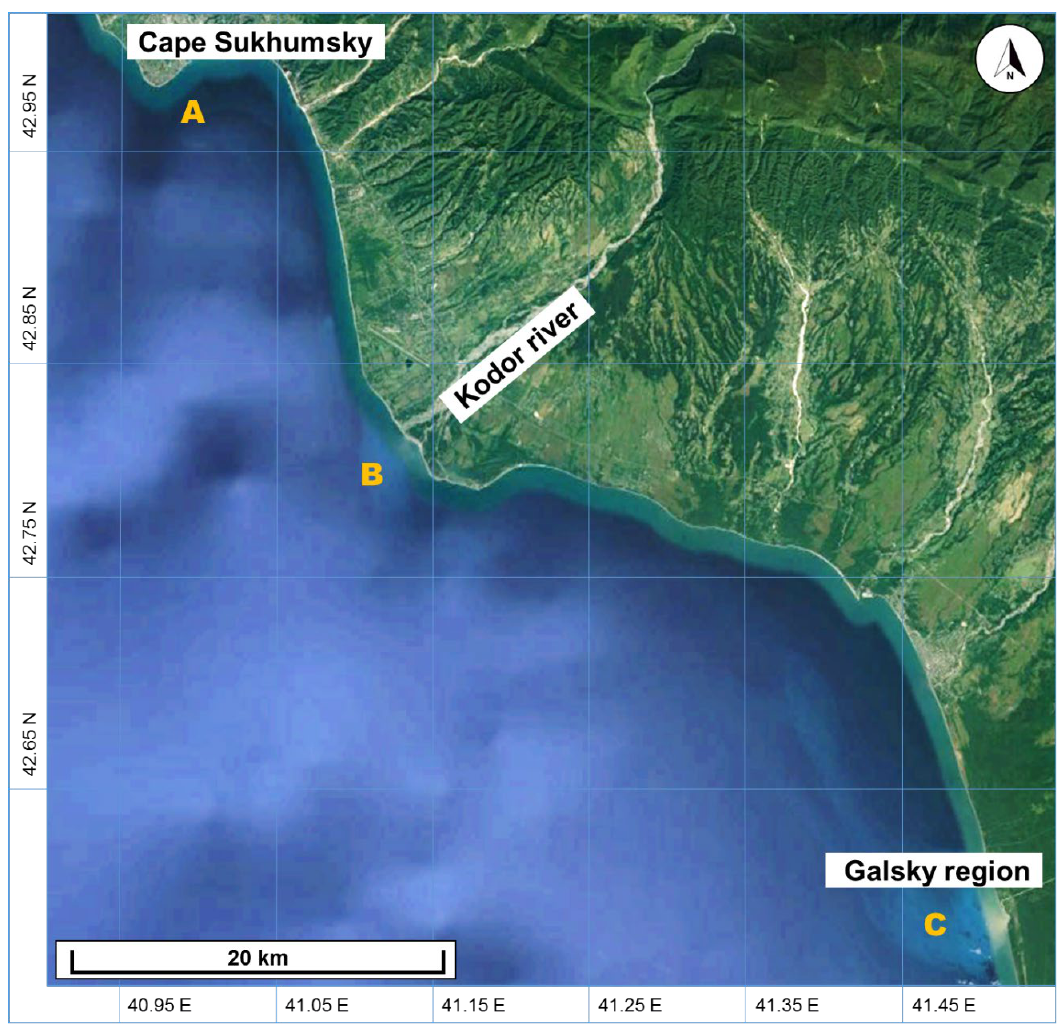
Figure 1. A schematic map (Google Earth) of the studied water areas indicating the analyzed areas ( A ), ( B ), and ( C ) of the Abkhazian shelf.